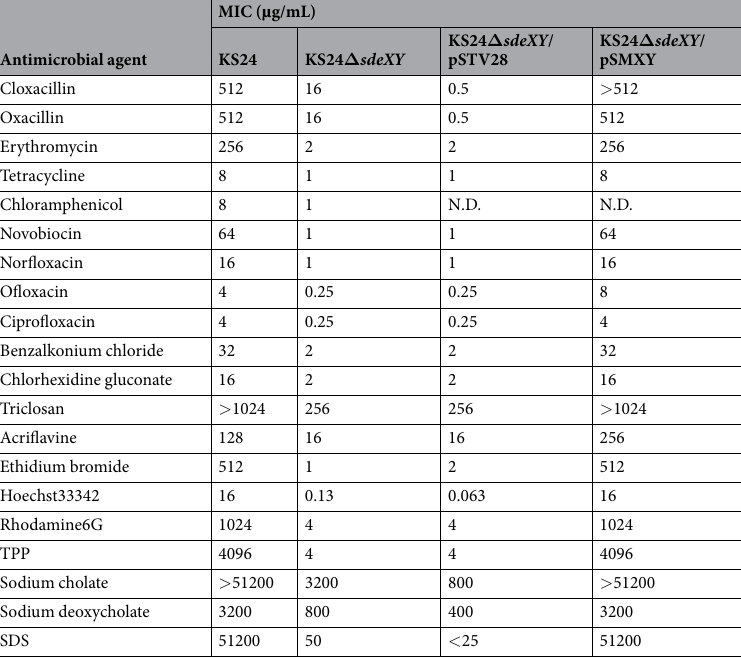
Table 3. MICs of antimicrobial agents in S . marcescens . N.D.; not determined, TPP; tetraphenylphosphonium chloride.